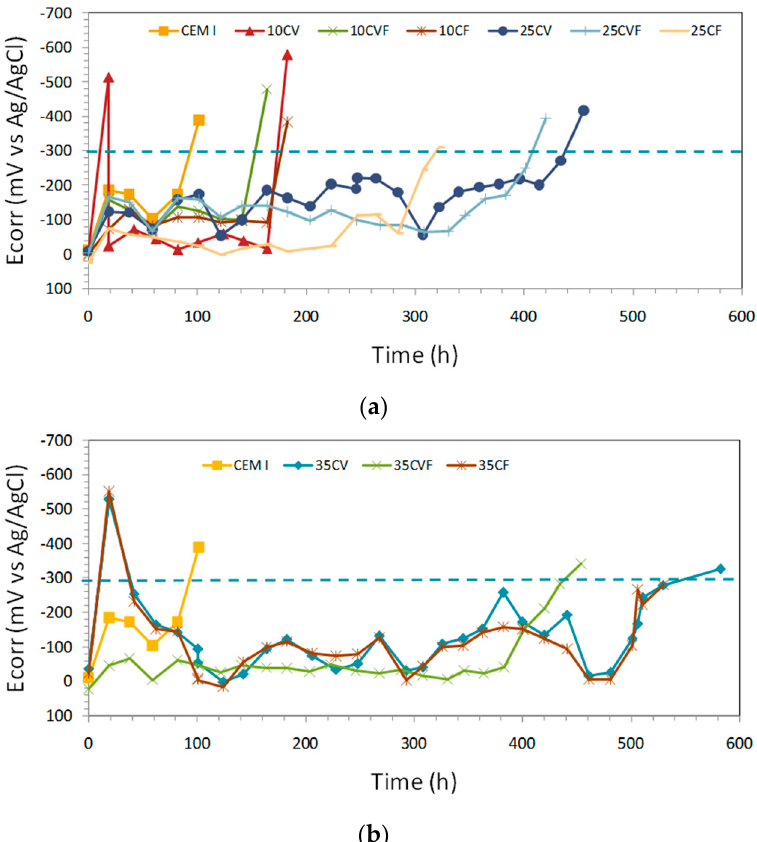
Figure 6. E corr vs. time. The different lines per plot represent the samples per mix: (a) samples CEM I, 10CV, 10CVF, 10CF, 25CV, 25CVF, 25CF; (b) samples CEM I, 35CV, 35CVF, 35CF. The dashed line indicates the E corr value for corrosion initiation (E corr = − 300 mV).